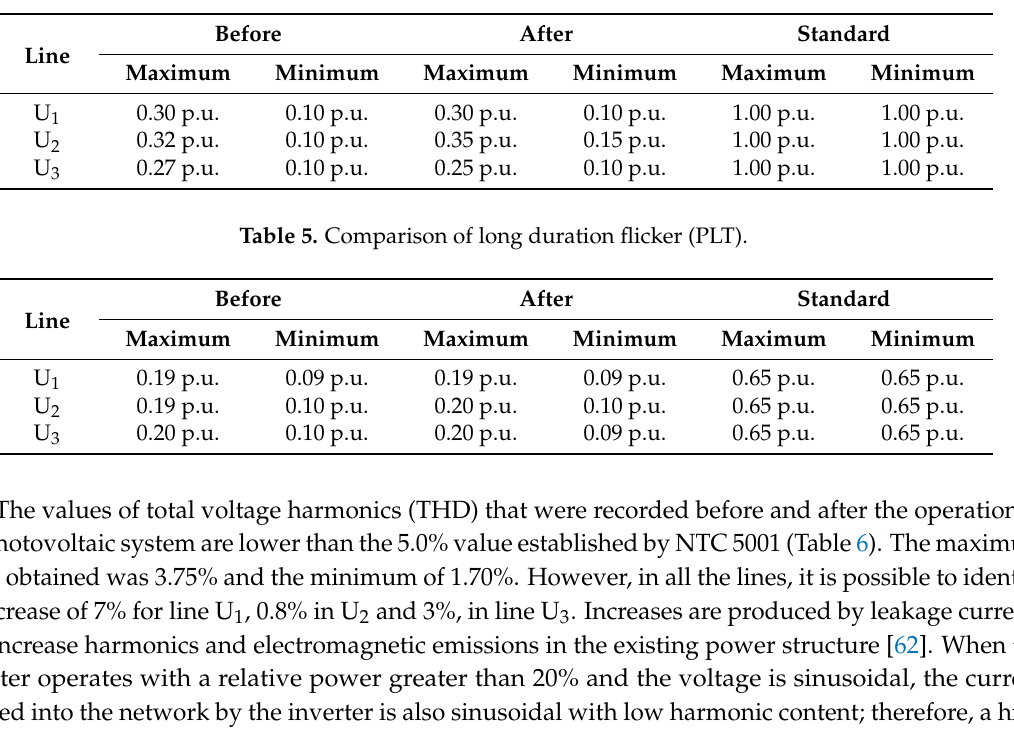
Table 4. Comparison of short duration flicker (PST).